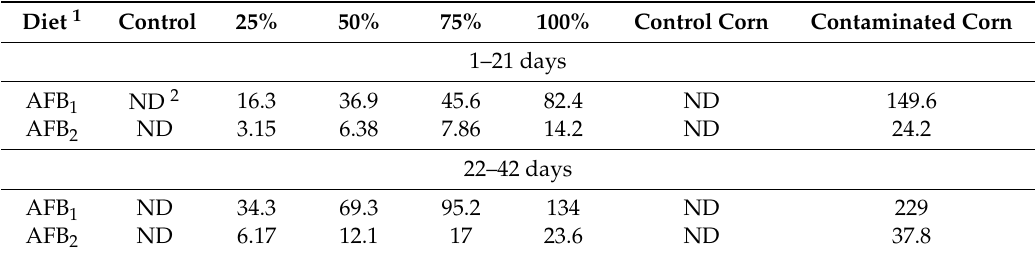
Table 1. Mycotoxin concentrations in diet and corn (air-dry basis µ